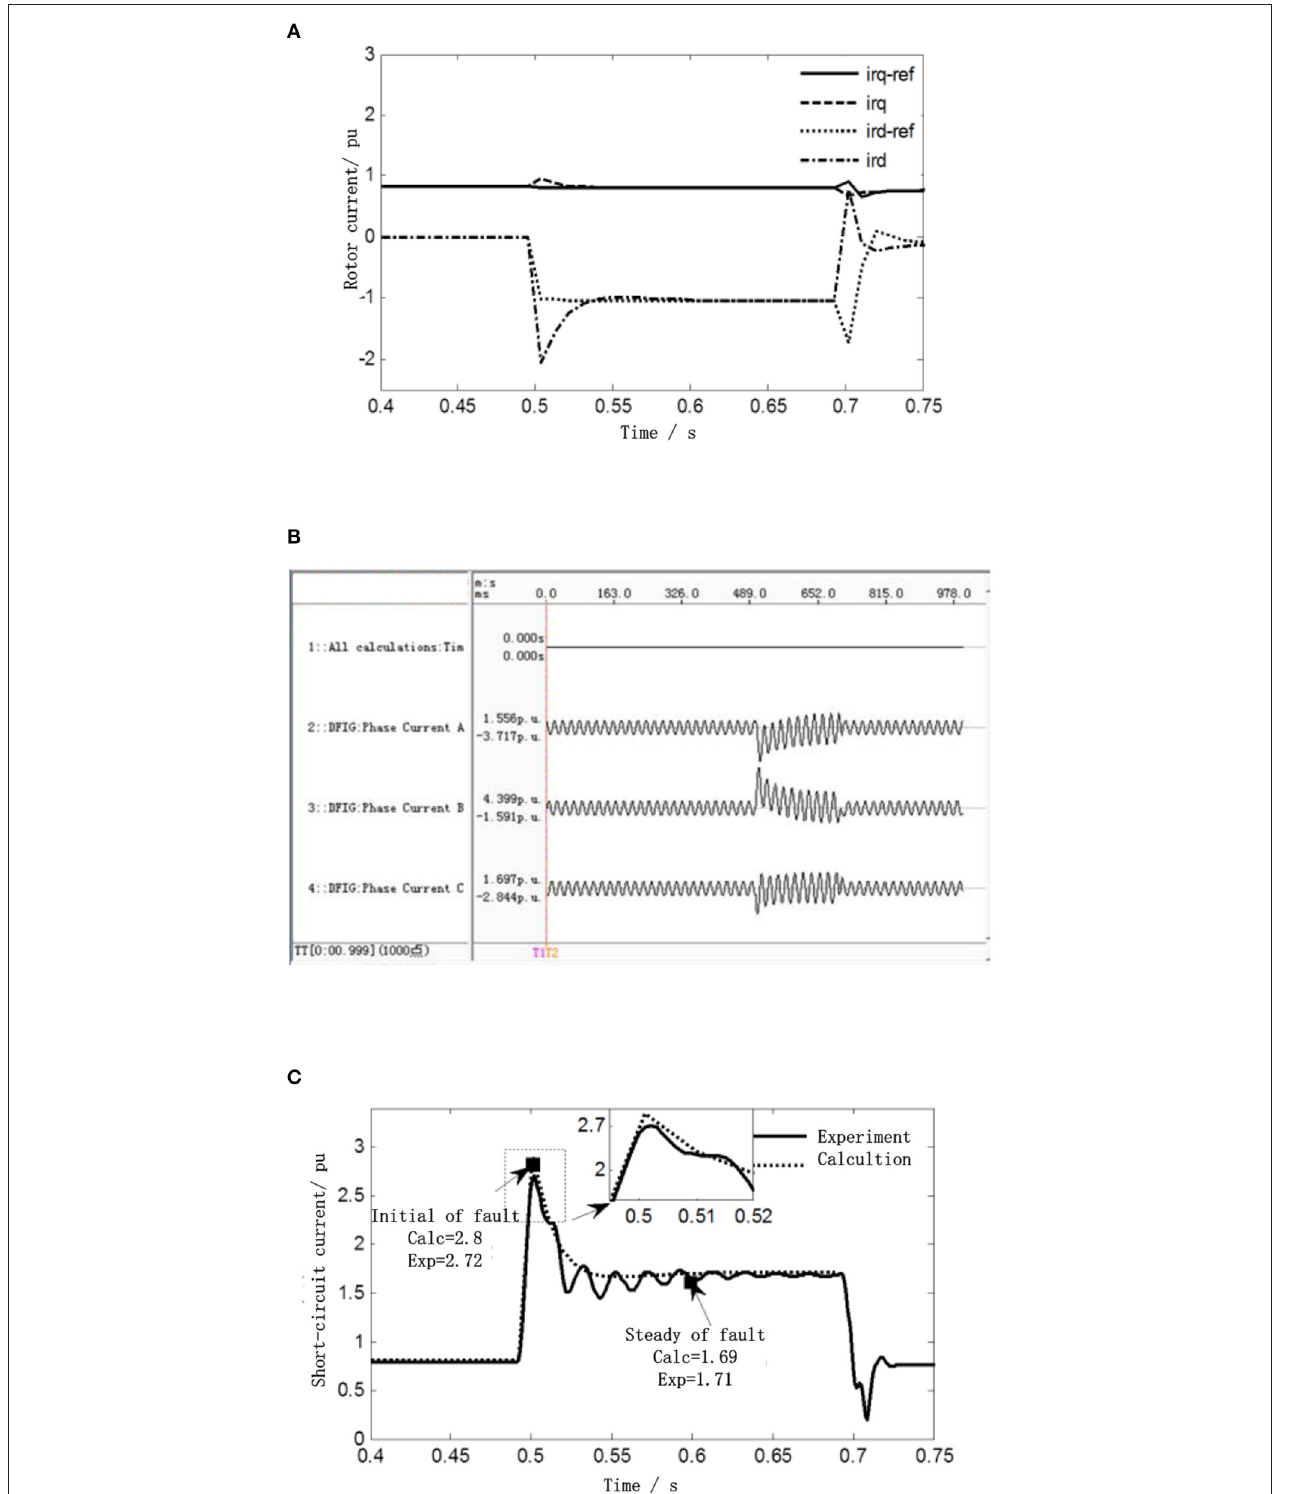
FIGURE 7 | Comparison figure between the calculation result and experimental result of DFIG three-phase short circuit at bus A. (A) Comparison of the rotor current control reference value and actual rotor value. (B) Experimental result of short-circuit current of three-phase short-circuit DFIG at bus A under 0.8 rated conditions. (C) Comparison of the calculation result and experimental result of RMS three-phase short circuit at bus A.